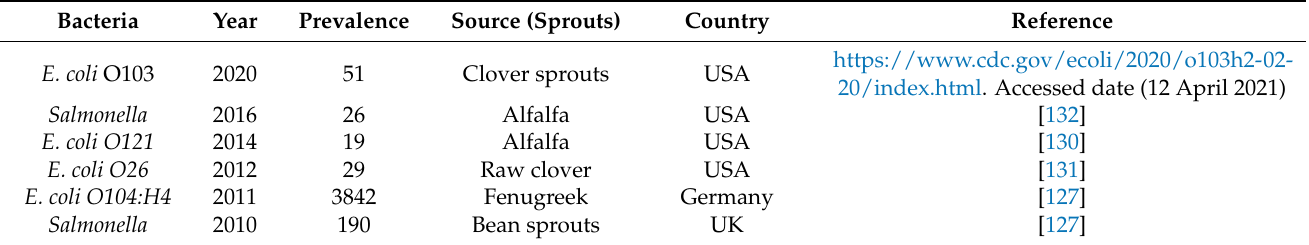
Table 2. Summary of microbial infection outbreaks associated with sprouts from 2010 to 2020.